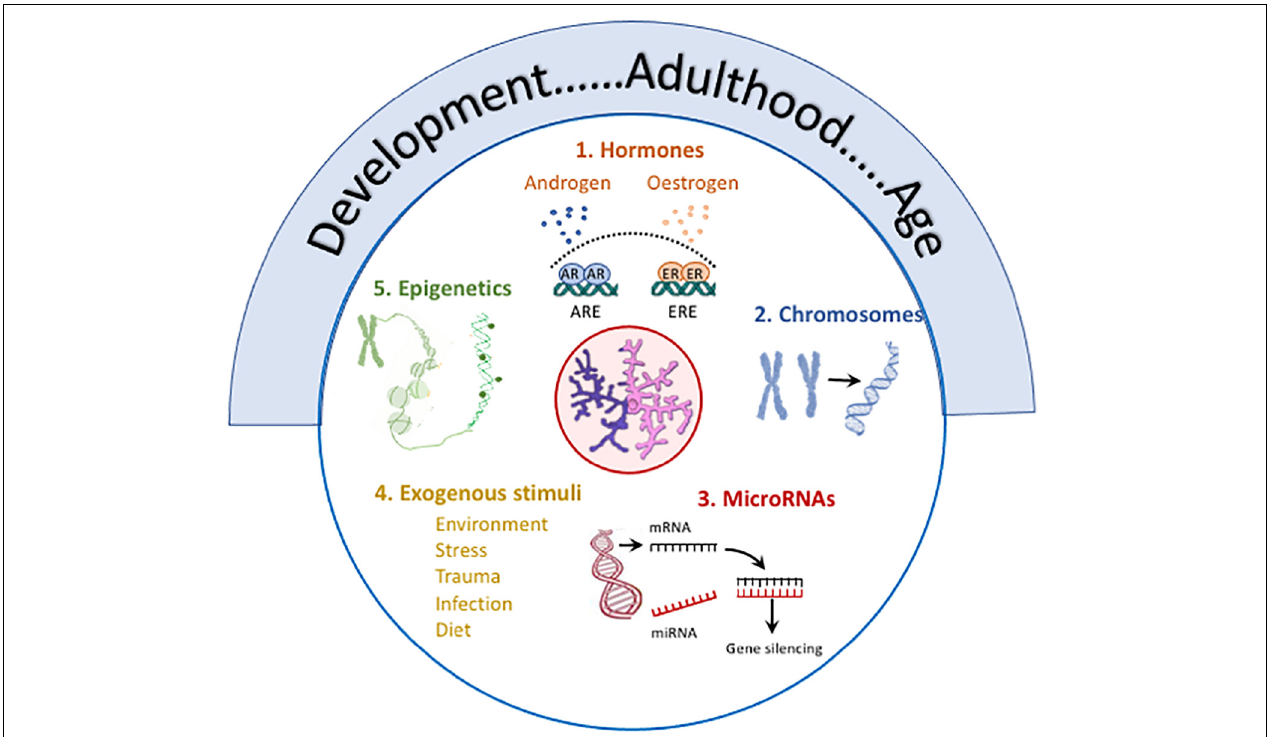
FIGURE 3 | Several factors contribute to sex differences in microglia. Age, from development to old age, is marked by changes in microglia including changes in number, size, function (phagocytic, motility, antigen presentation, secretory), metabolism, expression of receptors and responses of activation stimuli, and transcriptomic signature, and age frequently impacts on other modulatory factors. (1) Hormones: Androgen and estrogen receptors, which are expressed in microglia, exert multiple effects with evidence of sex-specific changes. For example, estrogens trigger activation of estrogen response elements which alters immune mediator production (Acosta-Martinez, 2020), impacts on function (Nelson et al., 2017), attenuates LPS-induced changes (Loram et al., 2012) and modulates age-related inflammation (Villa et al., 2016; Lenz and Nelson, 2018; Acosta-Martinez, 2020) in a sex-specific manner. Androgen receptor expression on microglia is increased following TBI, and testosterone reduces TBI-induced reactive microgliosis and also LPS-induced cytokine production in vitro and microgliosis in vivo (see review McGovern and Baretto, 2021). (2) Chromosomes: X and Y chromosome genes encode for proteins with different immune functions e.g. (Klein and Flanagan, 2016; Lefevre et al., 2019). The development of the four core genotypes model have identified the contribution of chromosomes to sex-related differences in EAE (Smith-Bouvier et al., 2008) and a model of AD (Davis et al., 2020) both of which are characterized by changes in microglia. (3) MicroRNAs: Sex-related differences in microRNAs that regulate immune networks have been identified in microglia (Kodama et al., 2020) and depletion of Dicer in microglia leads to upregulation of genes reflecting immune activation and inflammation in males. (4) Exogenous stimuli: Sex-specific responses to environmental factors e.g., maternal deprivation, stress, trauma, infection, diet in microglia have been reported (see text). (5) Epigenetics: Epigenetic processes modulate microglia (Cheray and Joseph, 2018) and epigenetic changes [mono-methylation at lysine 4 of histone 3 (H3K4me1) and acetylation at lysine 27 of histone 3 (H3K27ac)] that support LPS-induced immune memory, controls production of inflammatory molecules in models of AD and stroke and triggers neuropathology (Wendeln et al., 2018). Specific sex-related differences in remain to be